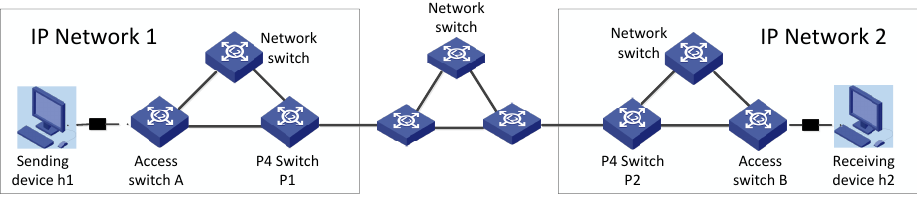
Figure 15. Evaluation testbed of IPsec.